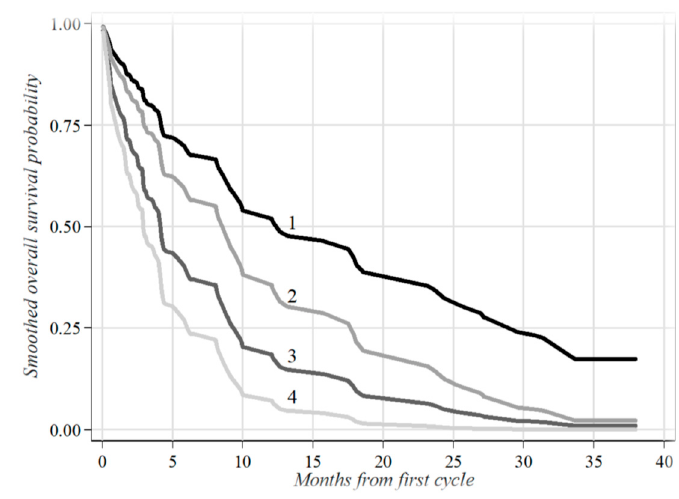
Figure 2. Survival probabilities estimated through the Cox regression modeling in four risk subgroups. The risk subgroups were identified by cross-classifying patients according to the two categories of both biomarkers evaluated at baseline (CTCs: ≤ 2 and > 2; cfDNA: ≤ 836.5 and > 836.5) considered as time-dependent covariates ( p < 0.001). 1 —CTCs ≤ 2 and cfDNA ≤ 863.5, HR = 1.00 (Reference